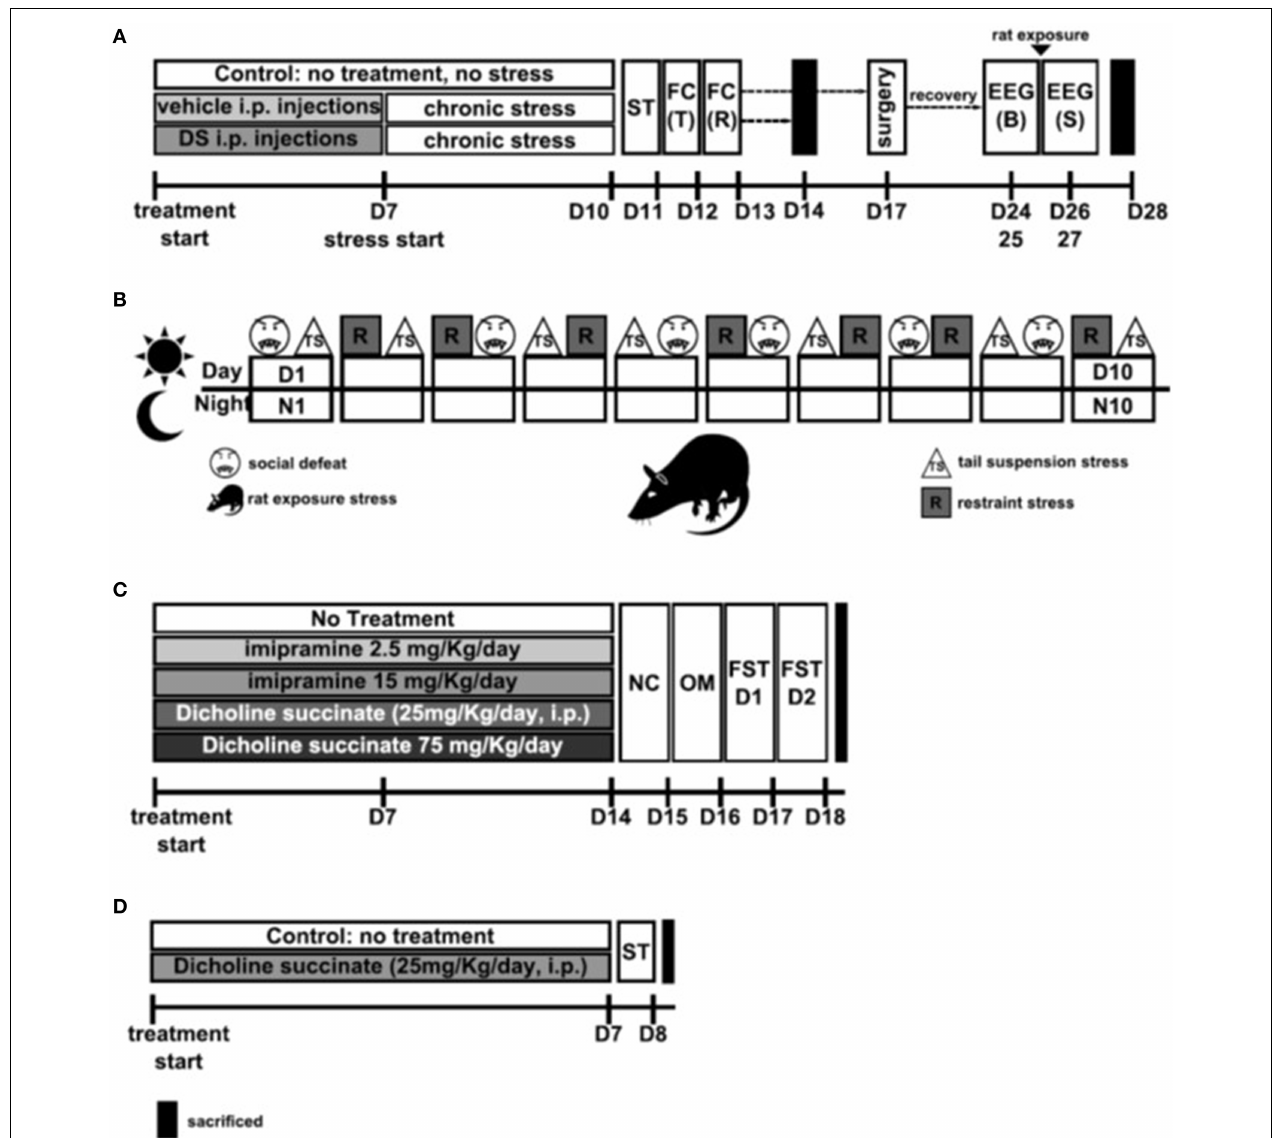
FIGURE 1 | Study flows. (A) Study of the effects of Dicholine Succinate in a chronic stress model. Abbreviations: DS, dicholine succinate-treated; ST, sucrose test; FC, fear conditioning; T, training; R, recall test; B, baseline; S, stress; D, day of experiment. (B) Schematic of the 10 day chronic stress procedure. Abbreviatons: TS, tail suspension stress; R, restraint stress; D, day; N, night Rat: rat